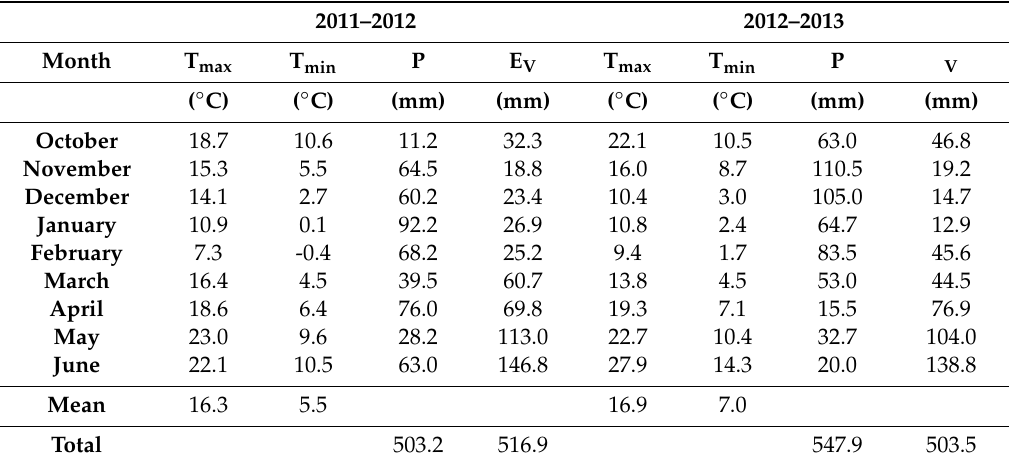
Table 1. Mean monthly climatic parameters recorded during the 2011–2012 and 2012–2013 growing seasons of the chamomile